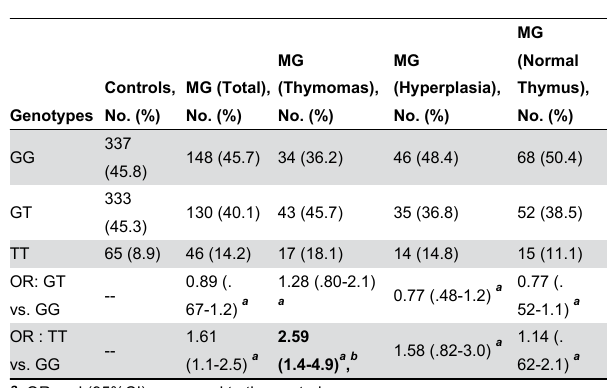
Table 3. DNMT3B -579G>T genotype frequencies in Myasthenia Gravis patients and